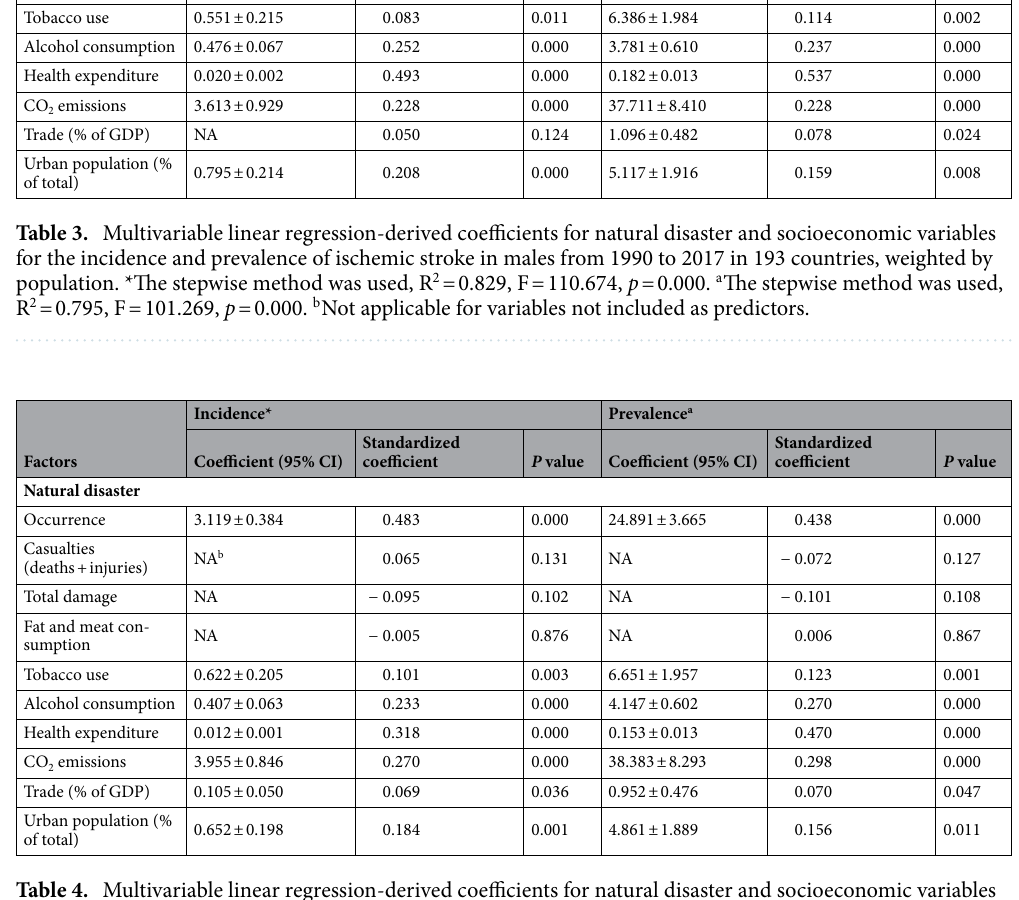
Table 4. Multivariable linear regression-derived coefficients for natural disaster and socioeconomic variables for the incidence and prevalence of ischemic stroke in both sexes from 1990 to 2017 in 193 countries, weighted by population. *The stepwise method was used, R 2 = 0.818, F = 117.759, p = 0.000. a The stepwise method was used, R 2 = 0.786, F = 96.085, p = 0.000. b Not applicable for variables not included as